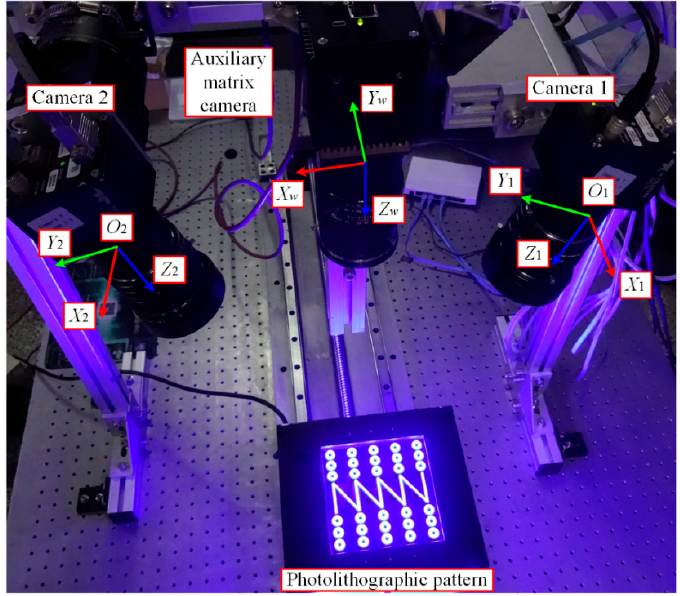
Figure 10. Calibration of the sensor.